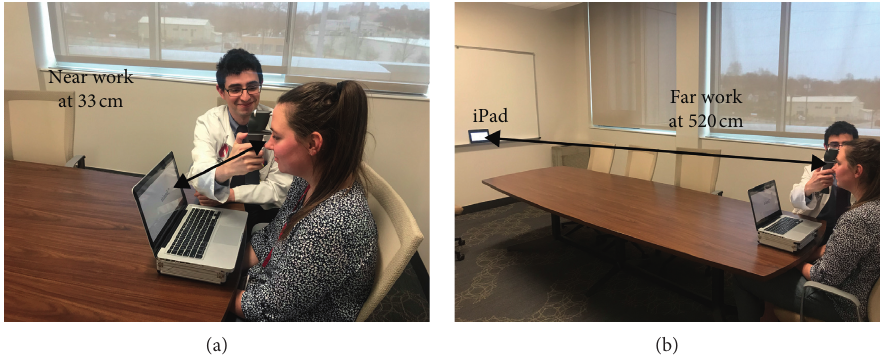
Figure 1: IOP measurements during near (a) and far (b) work.